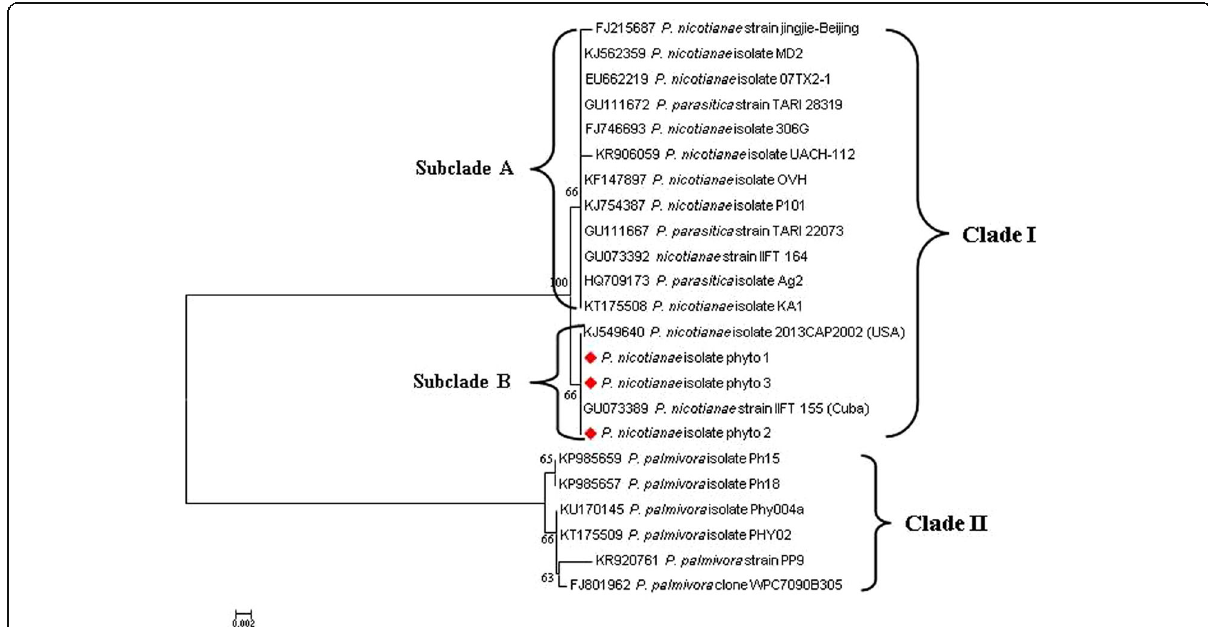
Fig. 8 Phylogenetic tree derived from the internal transcribed spacer (ITS) region sequences of Phytophthora nicotianae and other Phytophthora spp. isolates using the neighbor-joining method. The percentage of replicate trees in which the associated taxa clustered together in the bootstrap test (1000 replicates) is shown next to the branches. GenBank accession numbers for sequences are written in the left beside the Phytophthora sp. Phylogenetic